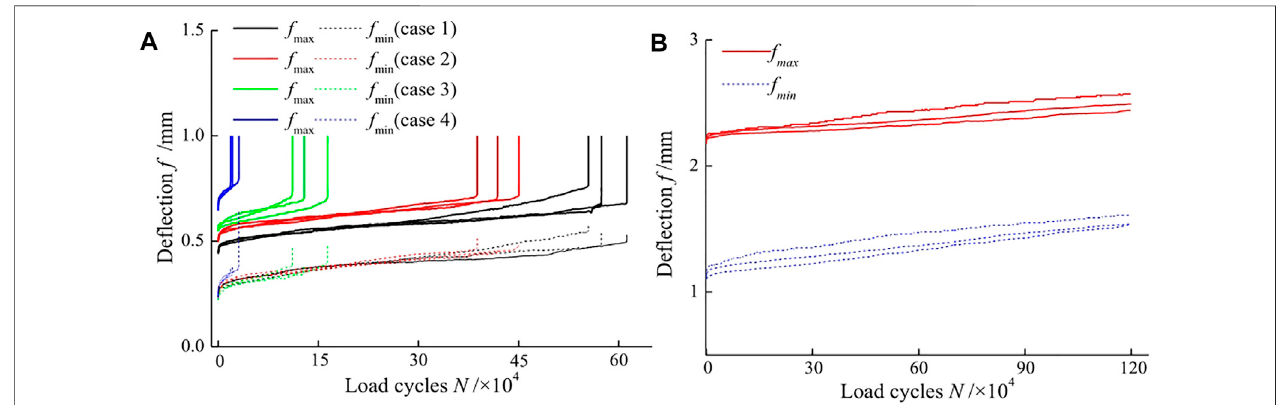
FIGURE 8 | De fl ection evolution curves. (A) cracked specimen; (B) unbroken